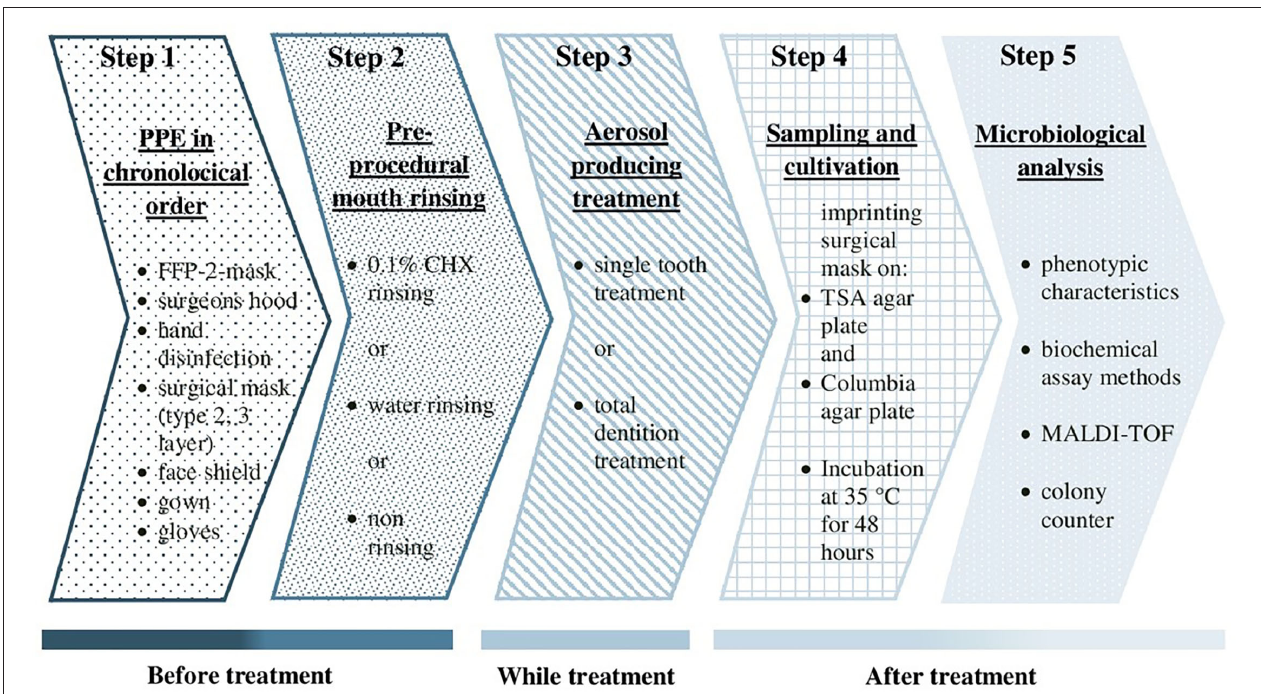
FIGURE 2 | Flow chart of the study. PPE, personal protective equipment; CHX, chlorhexidine; TSA, trypticase soy agar; MALDI-TOF MS, matrix-assisted laser desorption/ ionization time of flight mass spectrometry.